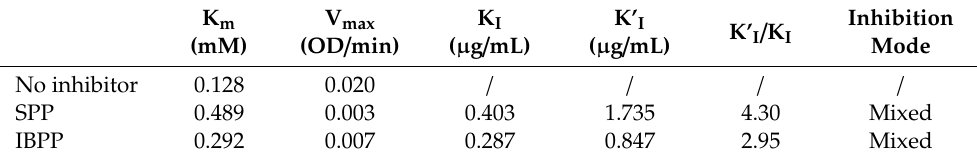
Table 1. Calculated inhibition kinetics parameters for the soluble (SPP) and the insoluble-bound